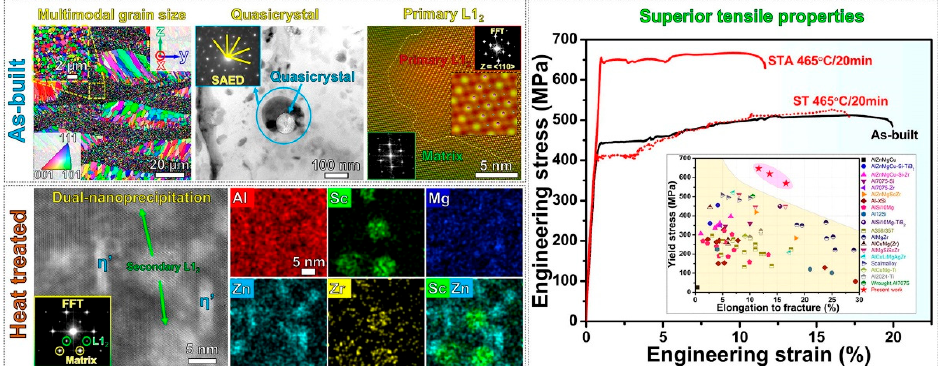
Figure 22. The engineering stress–strain curves of aluminum alloys prepared via SLM under different heat treatment processes, compared with the properties of other types of aluminum alloys. The microstructures of printed and annealed aluminum alloys were analyzed via electron microscope [110].